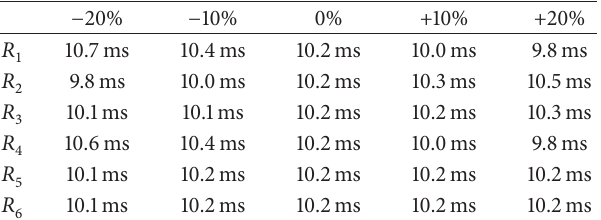
Table 5: Response time due to change in entire